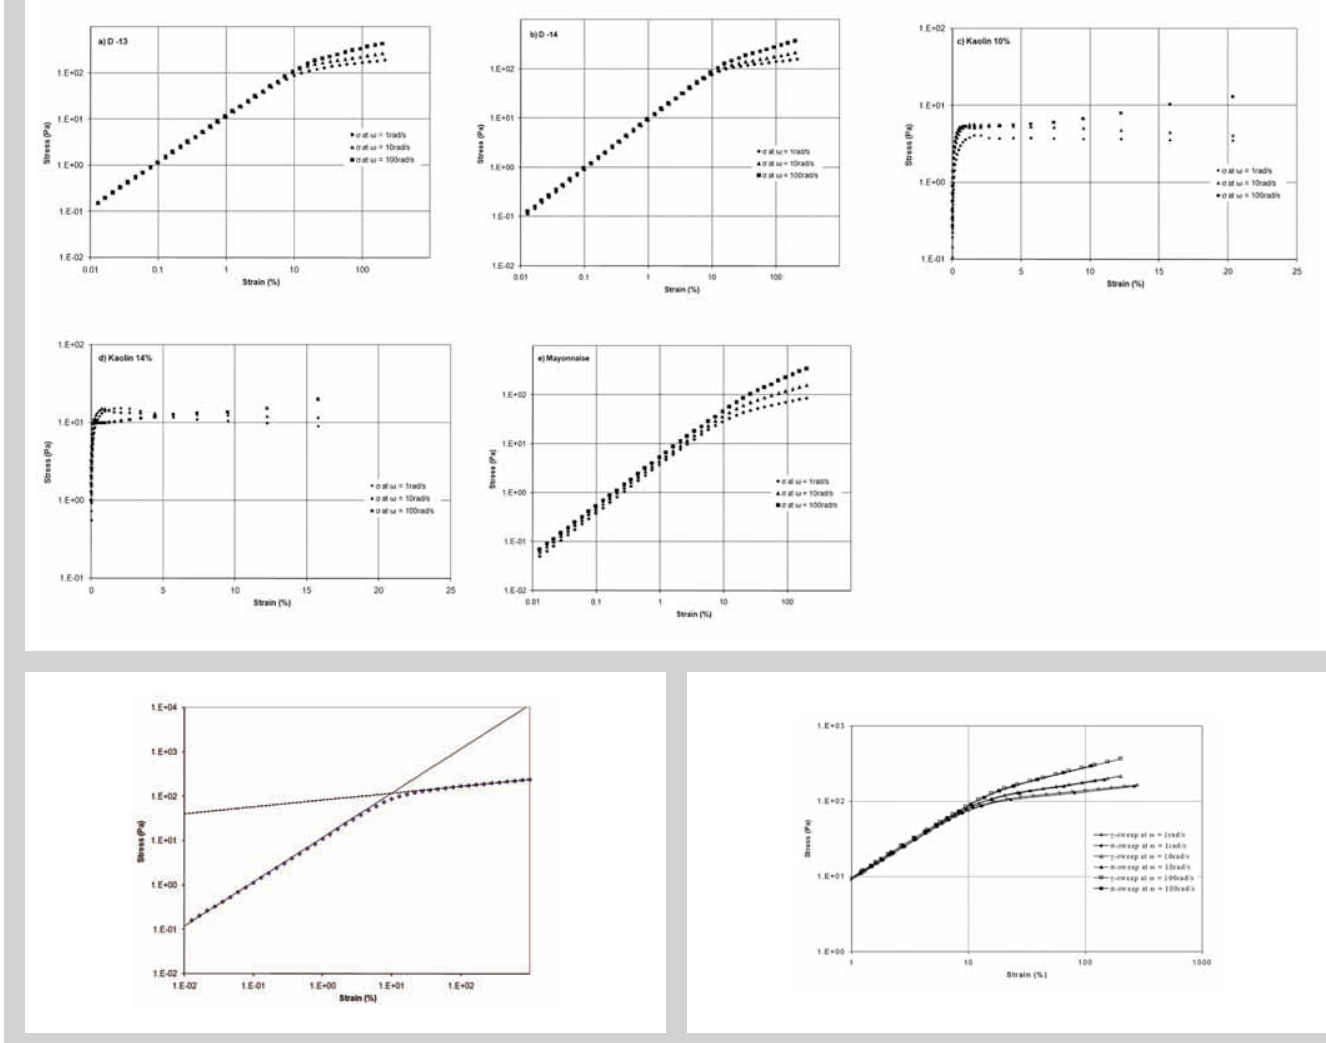
Figure 4 (above): Stress vs. strain curve at three angular frequencies for dif- ferent samples (The data for the suspension samples are presented in semi-log scale for better visibility). Figure 5 (left below): Stress versus strain depen- dence for D-13 sample at angular frequency 1 rad/s. The symbols show the exper- imental points, while the sol- id line shows the fitting of Hooke law and the dashed line shows the fitting by the power-law nonlinear rela- tion s = a g n Figure 6 (right below): The stress versus strain curve of D-14 sample at different angular frequencies and two different sweeping, stress and strain modes (lines are just for directing